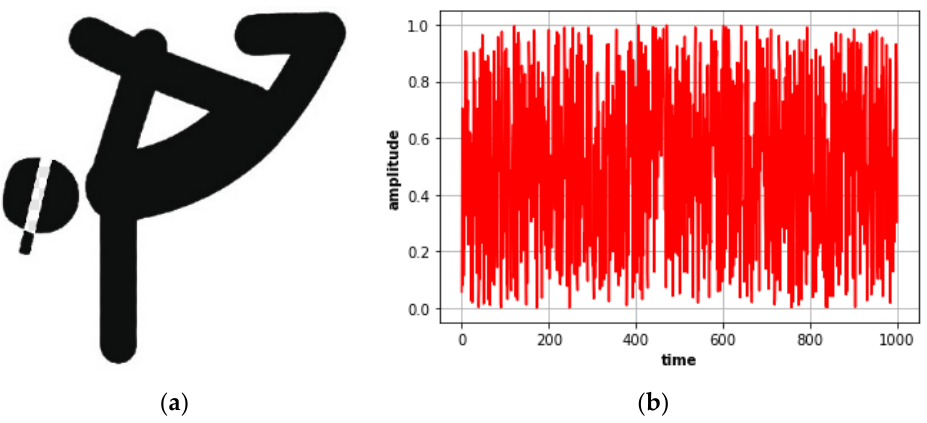
Figure 15. Failure cases for SSRDC system: ( a ) complex activity and ( b ) extreme signal distortion.